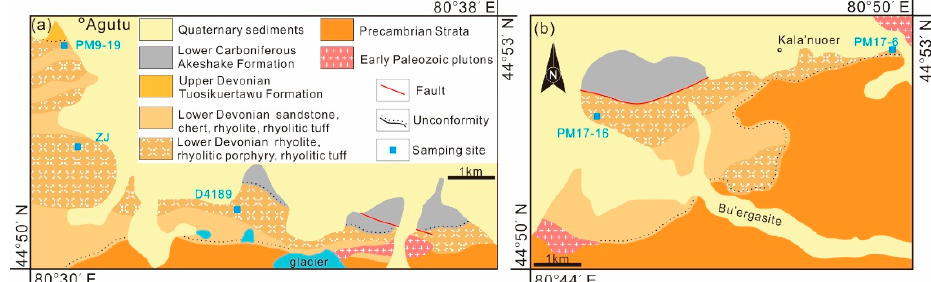
Figure 2. Detailed geological map of Early Devonian volcanic rocks in Agutu area ( a ) and Buergasite area ( b ) with sampling locations.